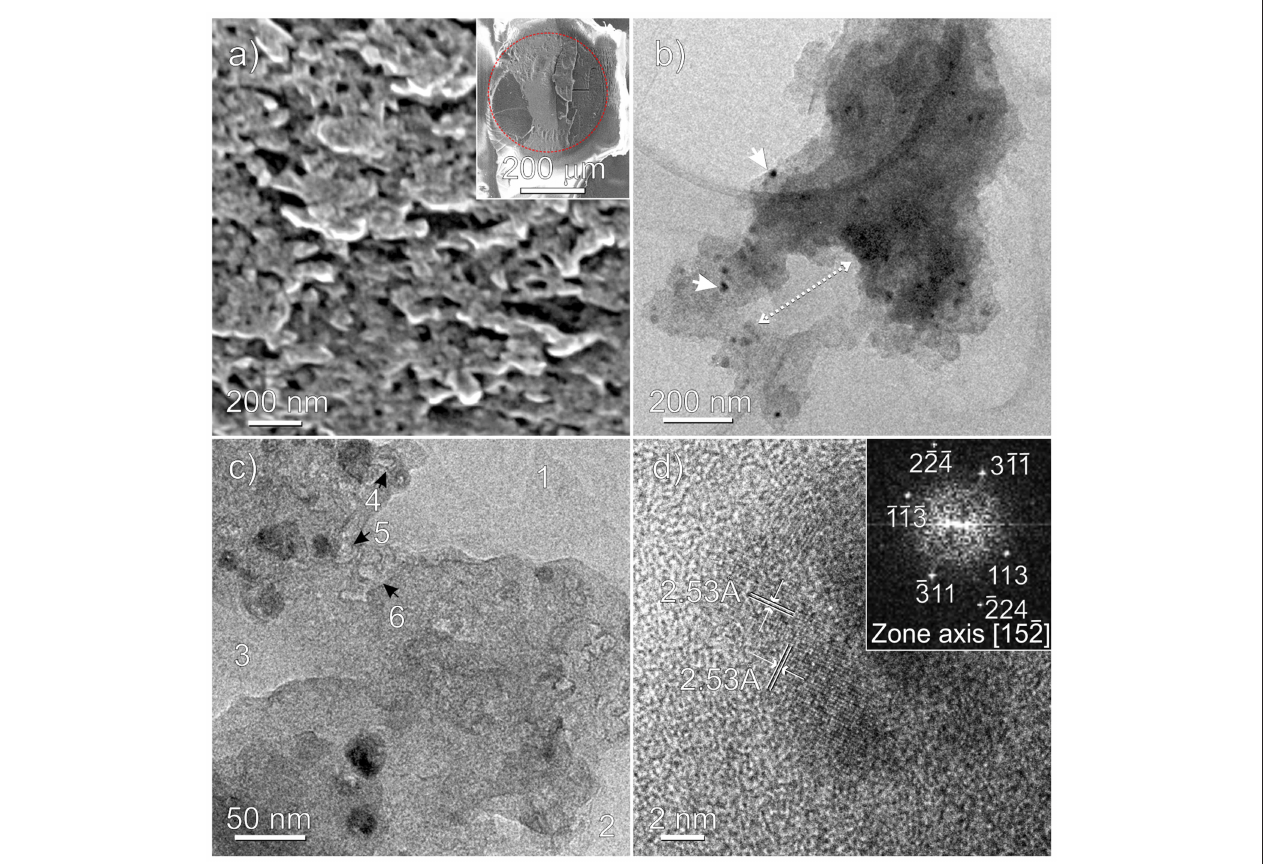
FIGURE 5 | Fe 3 O 4 -based ZnCl 2 /PS-co-DVB microspheres treated at 800 ◦ C: HRSEM (a) , TEM (b,c) , and HRTEM (d) images. A thin slice of a microsphere embedded in the epoxy resin after sectioning the specimen by ultramicrotomy is shown in the inset of (a) . The red dotted line evidences the embedded carbonaceous microsphere (darker region) from the epoxy resin (brighter region). Nanoparticles and macropores are highlighted in (b) , while 1, 2, 3 and 4, 5, 6 refer to macro- and mesopores in (c) , respectively. In the inset of (d) the selected nanoparticle is FFT